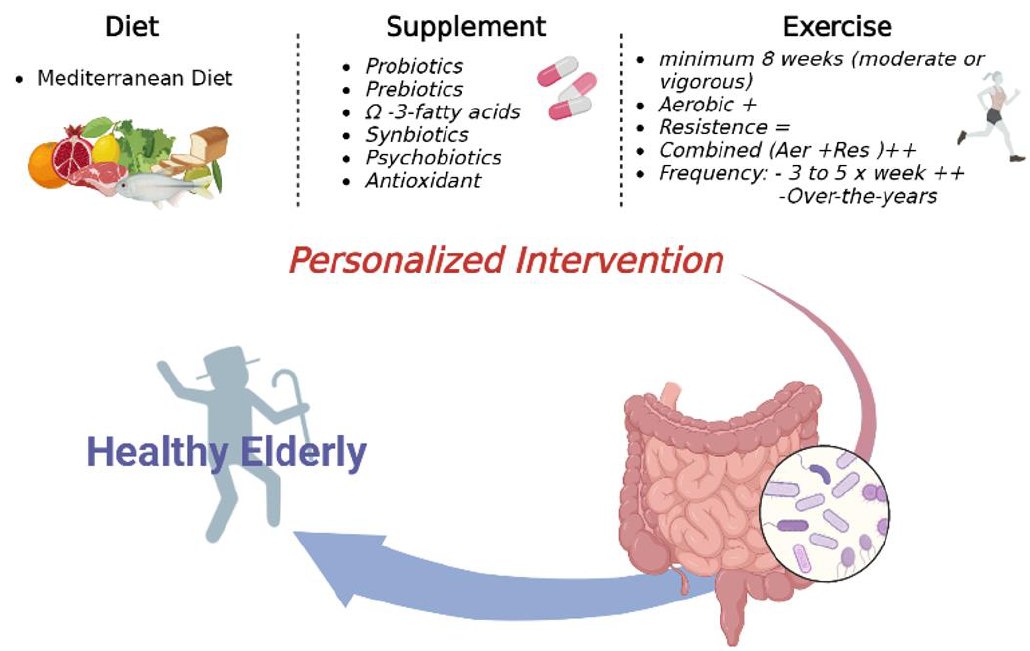
Figure 2. Personalized Interventions on microbiota to support healthy